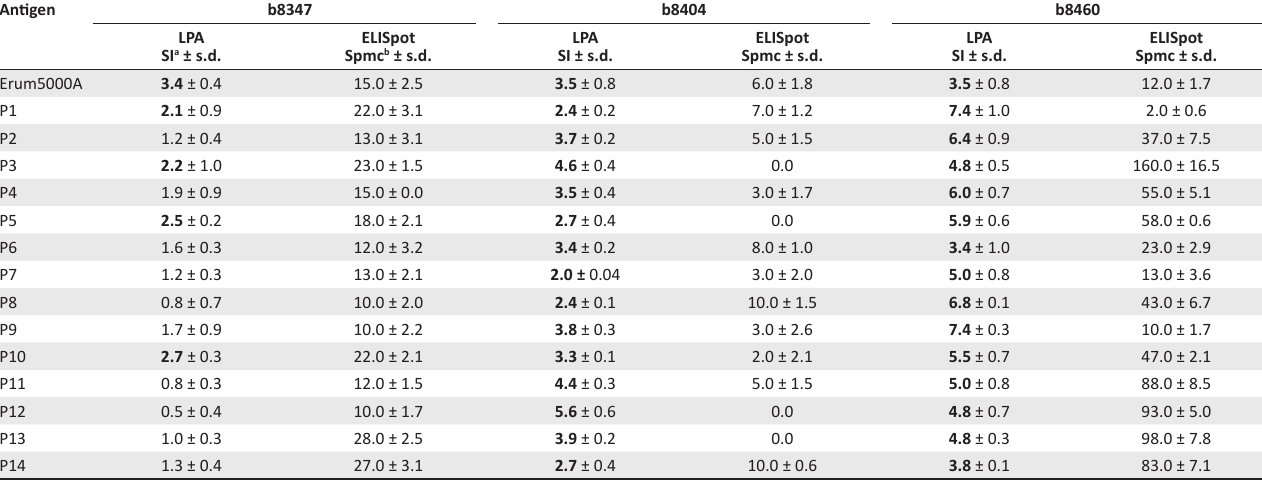
TABLE 5: Proliferative responses and IFN- γ production of peripheral blood mononuclear cells from immune bovine (b8347; b8404 and b8406) stimulated with rprotein and peptides. Cells were stimulated with peptides at a concentration of 10 mg/mL. Antigen b8347 b8404